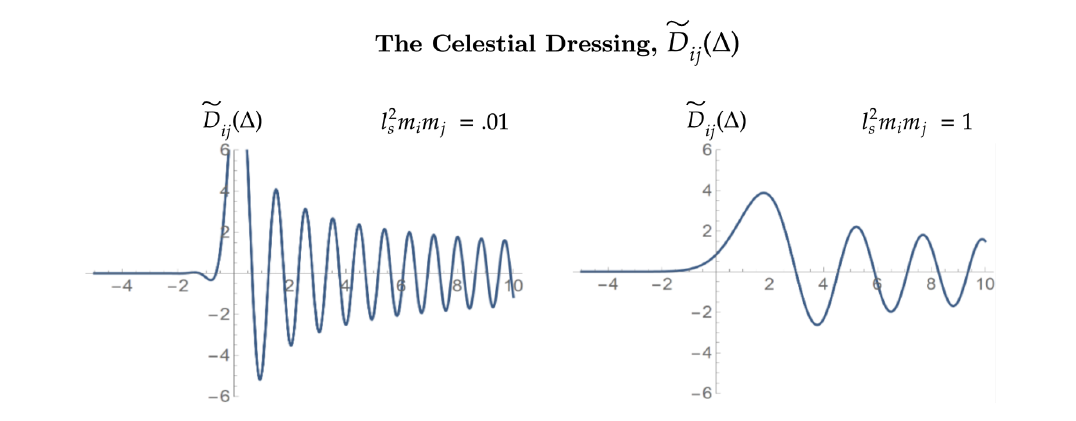
m i m j = 0 . 01 (weak gravity, left hand panel), for s